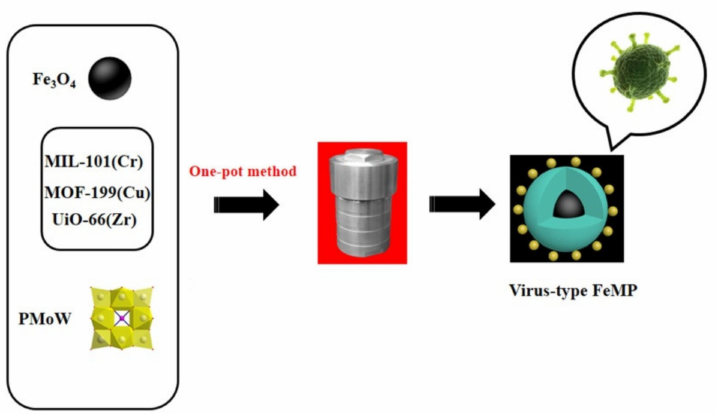
Figure 5. The scheme route to synthesis spinosus FeMP catalyst (reproduced from Ref. [19], copyright 2021